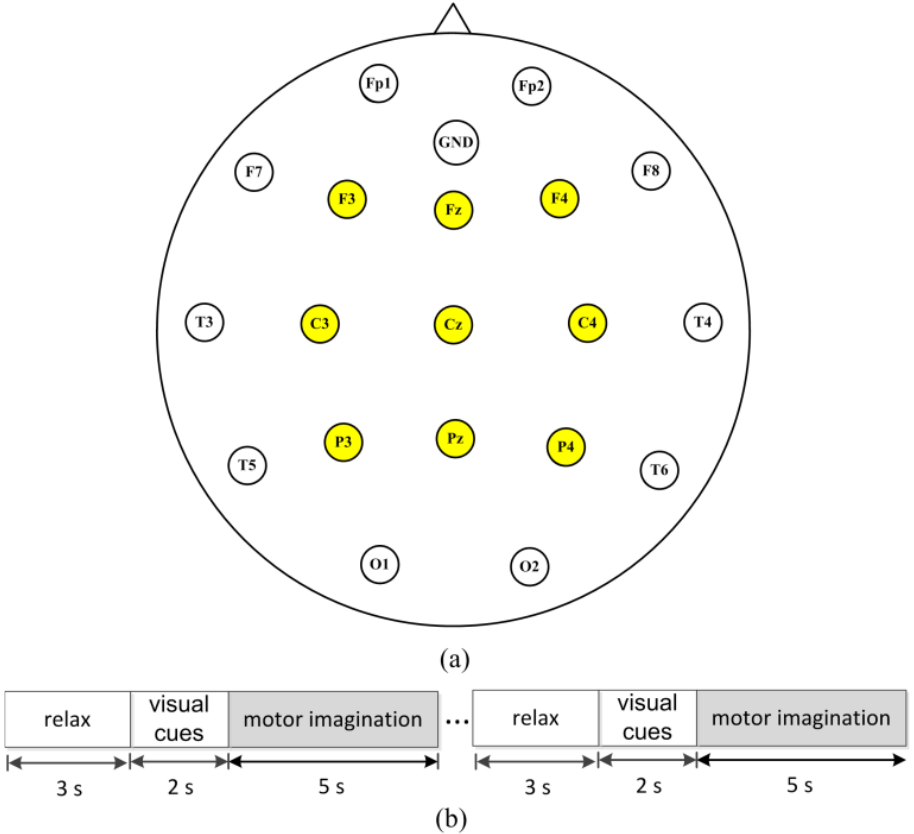
Figure 3. Experiment setup. ( a ) Electrodes used in the experiment (yellow circles) according to the international 10 − 20 system. ( b ) The scheme of the experiment. A single trial of the experiment was divided into three periods. In the first period, the subject relaxed for 3 s; and then the visual cues were indicated for 2 s for preparation. Finally, subjects performed the motor-imagery tasks (right hand or foot) for 5 s.